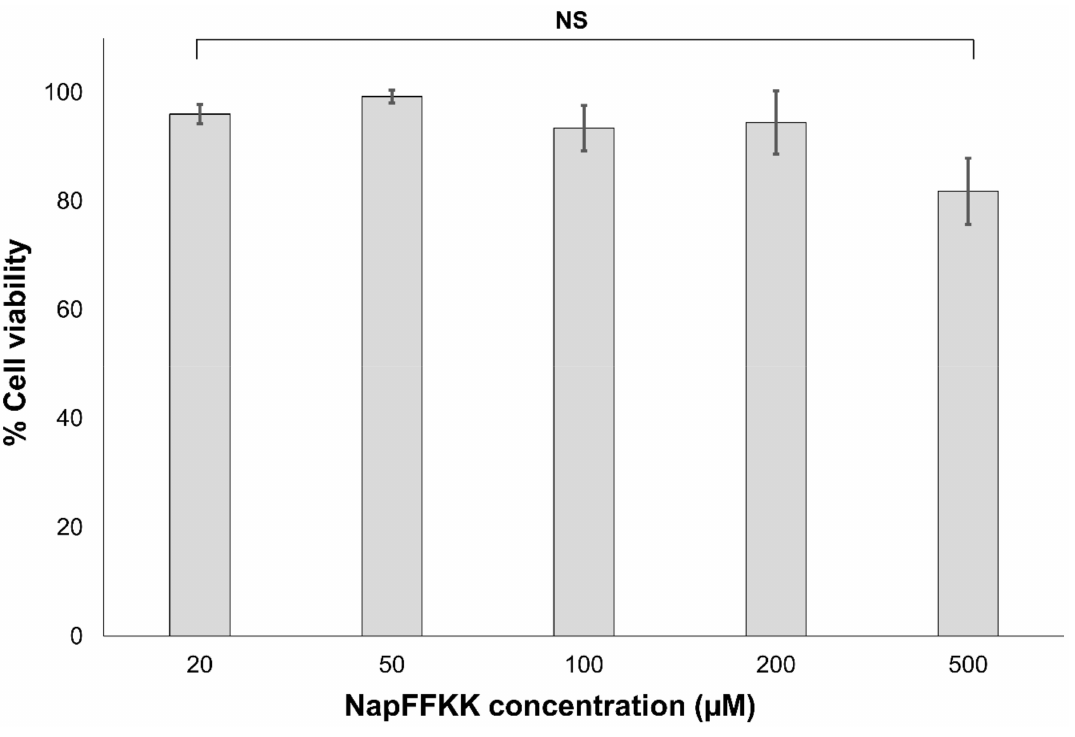
Figure 8. Percentage cell viability of NCTC clone 929 (ATCC CCL-1) cells after 24 h exposure to varying concentrations of NapFFKK-OH using CellTiter 96 ® AQueous One Solution assay. NS: no significant ( p ≥ 0.05) difference between NapFFKK-OH treatment and the negative control.